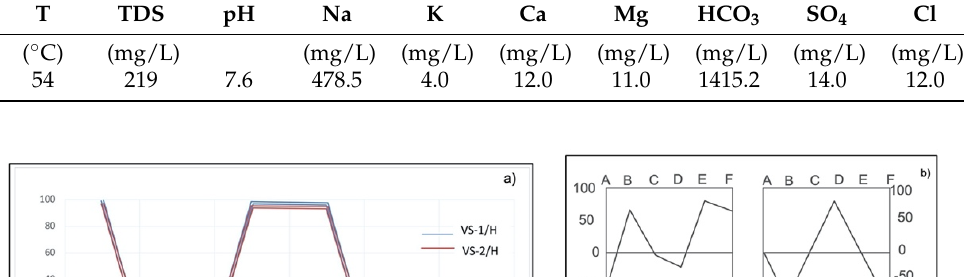
Table 6. Physical-chemical features of geothermal waters VS-2/H.